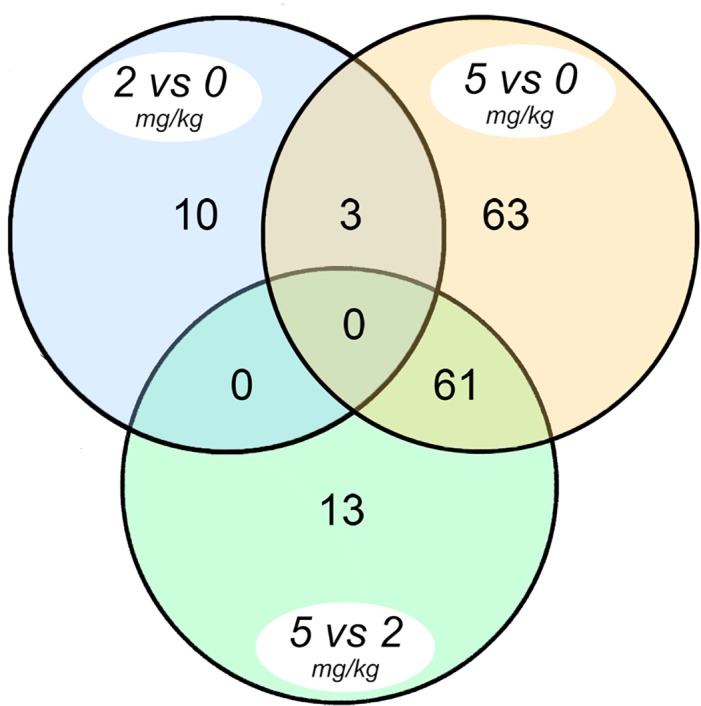
Venn diagram showing differential expression (>1.5-fold, p ≤ 0.05) of mRNAs that are unique as well as those shared by the three morphine dose contrasts indicated.